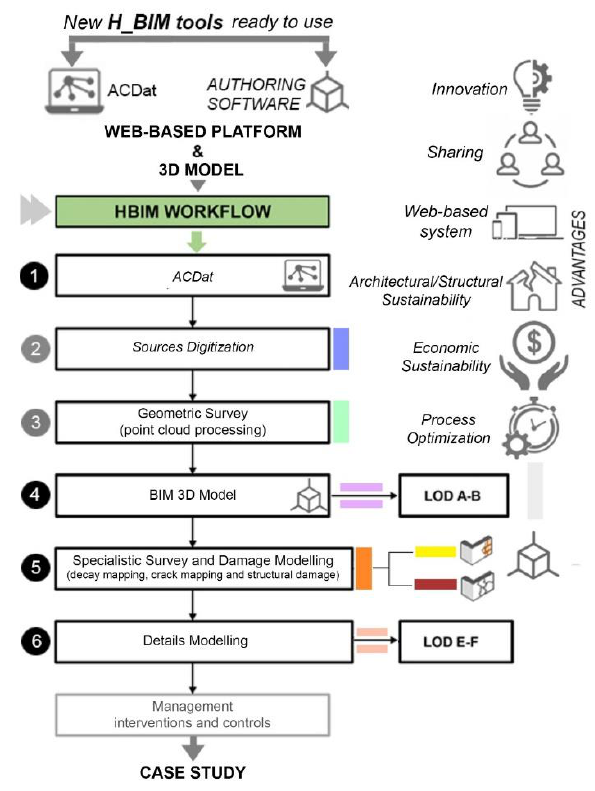
Figure 4 . H-BIM workflow: steps and